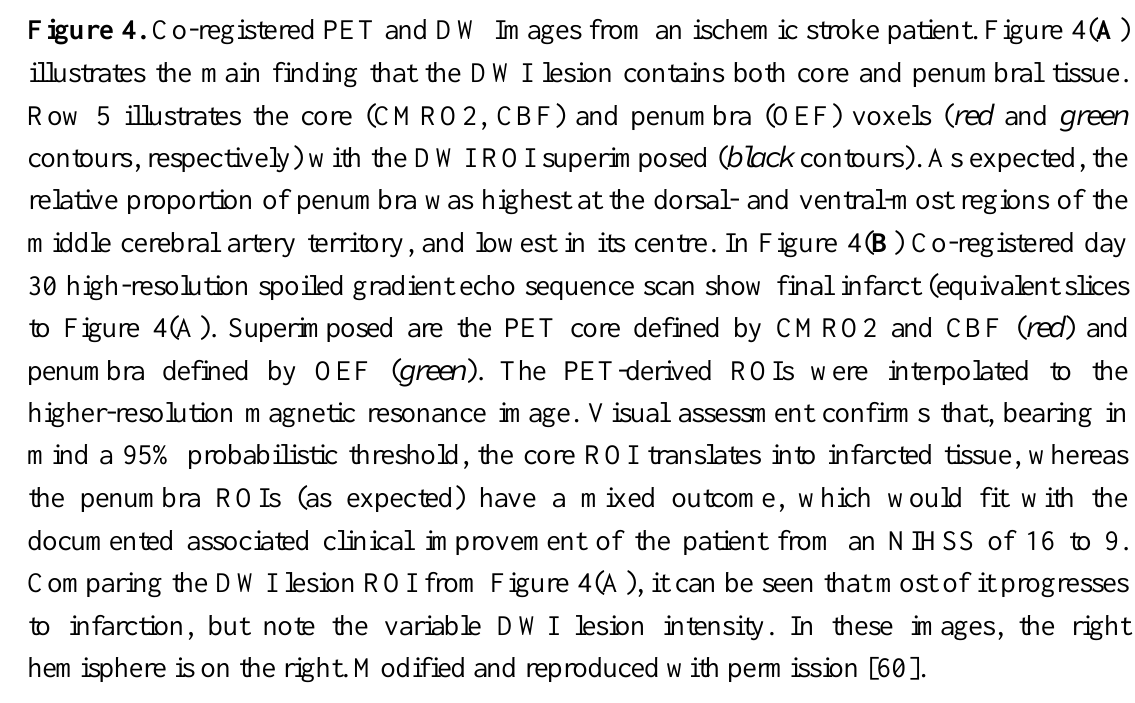
Figure 4. Co-registered PET and DW Images from an ischemic stroke patient. Figure 4( A ) illustrates the main finding that the DWI lesion contains both core and penumbral tissue. Row 5 illustrates the core (CMRO2, CBF) and penumbra (OEF) voxels ( red and green contours, respectively) with the DWI ROI superimposed ( black contours). As expected,